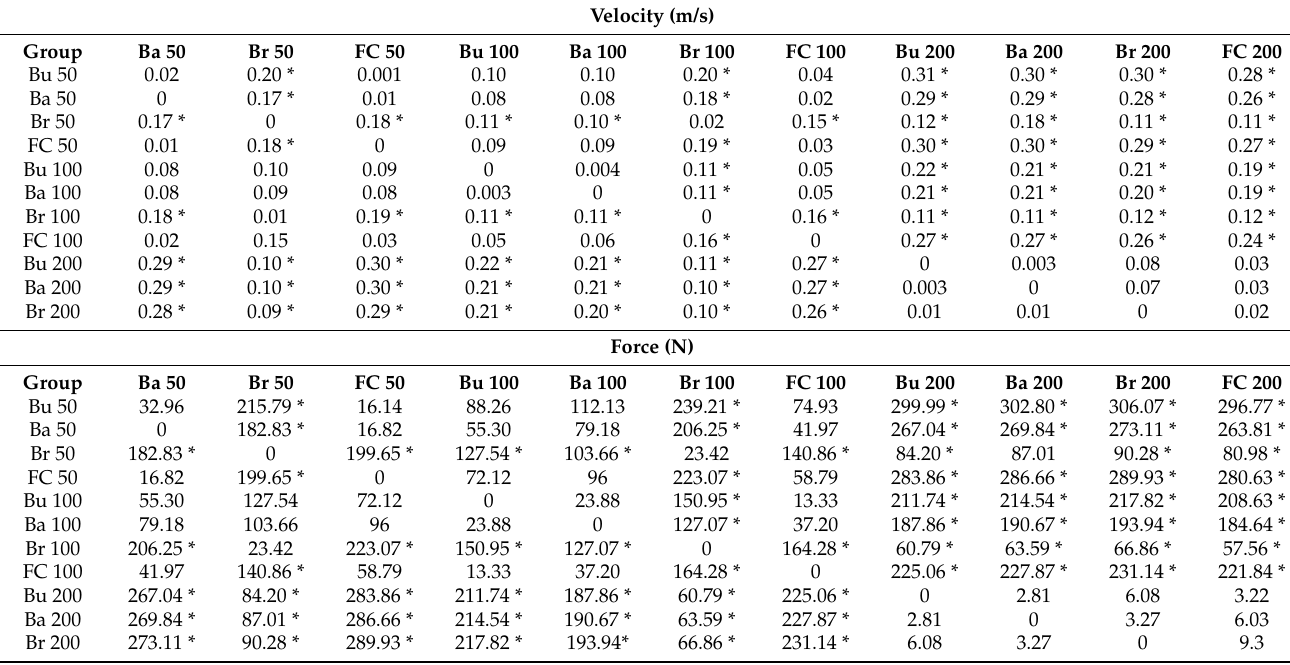
Table 4. Bonferroni post-hoc comparisons test for velocity (m/s) and force (N) across the experimental groups. The mean differences are shown. The asterisk * shows that the mean difference is significant